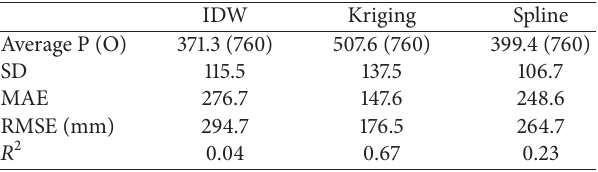
Table 7: Mean absolute error, RMSE, and 𝑅 2 values for the interpolation produced from validation of IDW, Kriging, and Spline